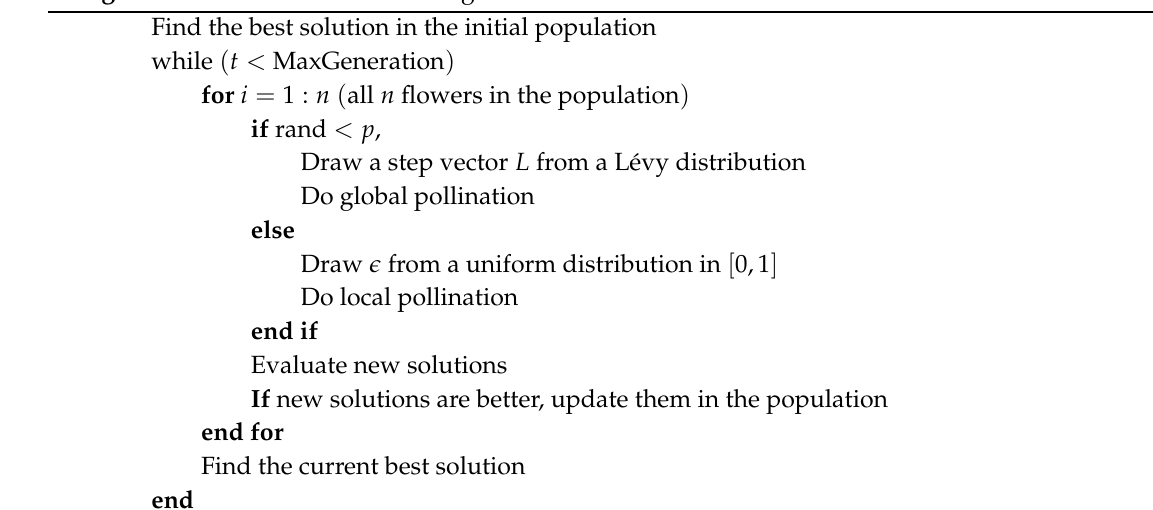
Algorithm 3: Flower Pollination